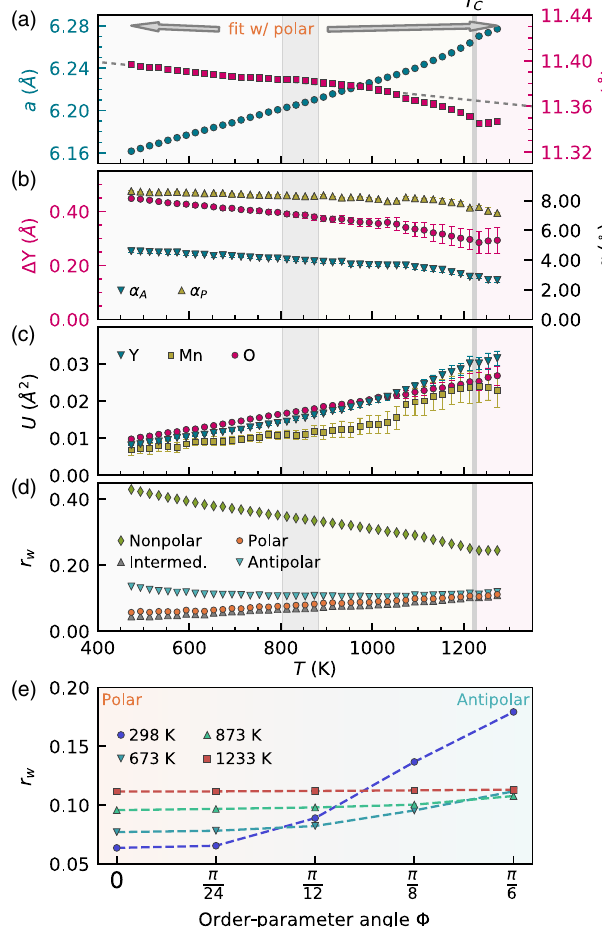
FIG. 5. Localstructurerefinements.(a)Refinedlatticeparameters from fitting G ð r Þ for r ¼ 1 . 6 – 22 Å with the polar space group model. (b) Y corrugation Δ Y, planar α , and apical α bipyramidal P A tiltangles,and(c)atomicdisplacementparameters U fromfittingthe polar model to the data in the range r ¼ 1 . 6 – 12 Å with fixed lattice parameters shown in panel (a) (see Supplemental Material [26] for details on the calculation of error bars). (d) Fit residual r for fitting w G ð r Þ between 1.6 and 12Å for the P model found at the minima and the AP model foundat the local maxima in the brim of the Mexican- hat potential using fixed lattice parameters found from refinements between 1.6 and 22 Å. The grey vertical line at 1223 K shows the Curie temperature T , and the grey shaded area between 800 K and C 880 K shows the temperature interval where refinements become incoherent. (e) Fitting error r as a function of the order-parameter w angleforarotationoftheanglebetweenthePandtheAPstructuresat constant amplitude. The amplitude for each temperature is shown in panel (b). Comparisons of the refined order-parameter observables and ADPs of the polar model with those of the antipolar and intermediate space group models are shown in Figs. S12 and S13, respectively, of the Supplemental Material